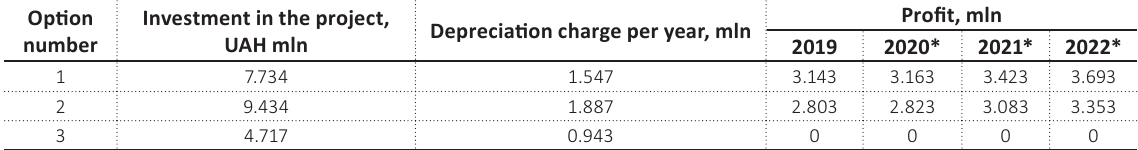
Table 4. Estimated data for choosing the option investment strategy Option number